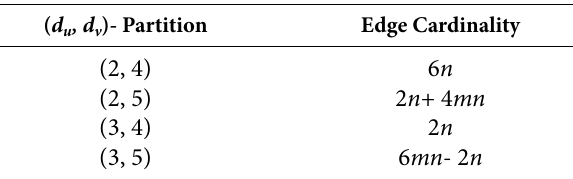
Table 2. The ( d u , d v )-type edge partition of titania TiO 2 [m, n] na- notubes . ( d u , d v )-